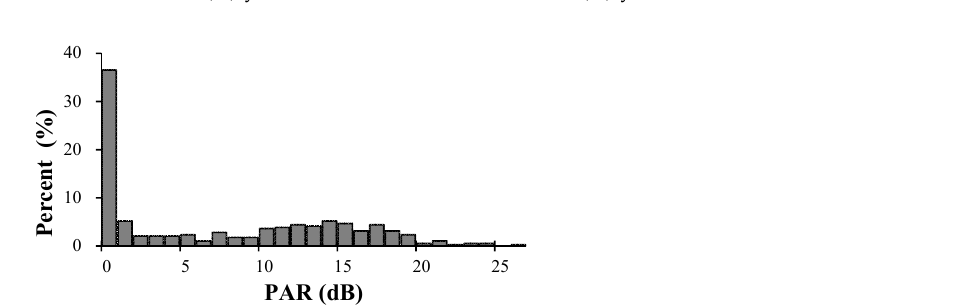
Figure 2. Histogram showing the distribution of personal attenuation ratings (PARs) achieved by percentage of the noise-exposed workers ( n = 385) in this study. The Pearson correlation between PAR and L Aeq,8h is − 0.032 ( p = 0.394). This indicates a slight negative linear relationship between PAR and L Aeq,8h , but it did not reach signifi- cance. Analysis of variance (ANOVA) testing shows that there was no difference in the mean PAR among L Aeq.8h groups (F = 0.657, p = 0.709), as shown in Figure 3. Male workers achieved higher attenuation than female workers (F = 4.342, p = 0.038).